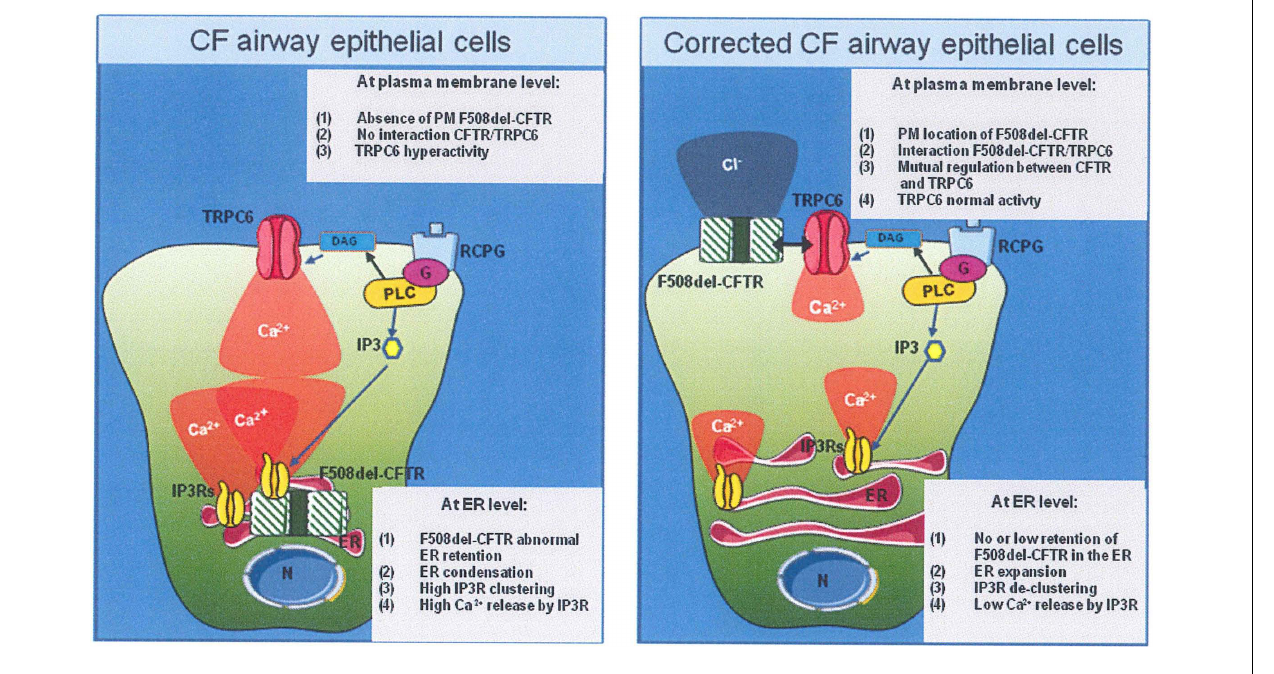
absence of the plasma membrane (PM) induced a hyper-activity ofTRPC6 Ca 2 + channel. (Right panel)The abnormal F508del-CFTR trafficking correction (pharmacologically or low temperature incubation) induced an ER network expansion. IP3Rs are more distant from each others, leading to reduce Ca 2 + release. At PM level, the F508del-CFTR interacted withTRPC6.This interaction seems to induce a normalization ofTRPC6 activity.